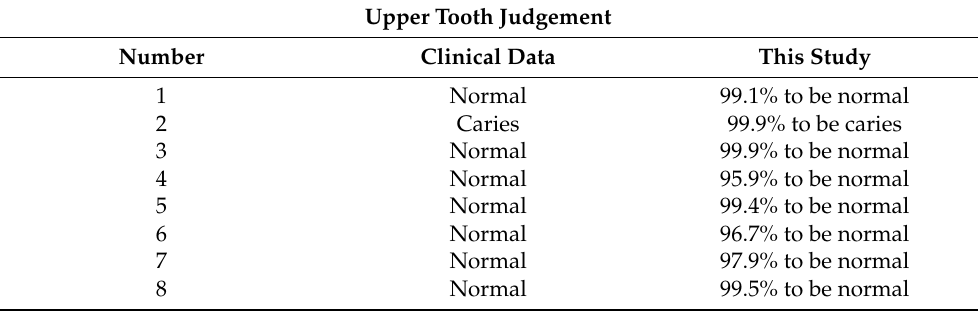
Table 4. Upper tooth judgement for the image in Figure 9.